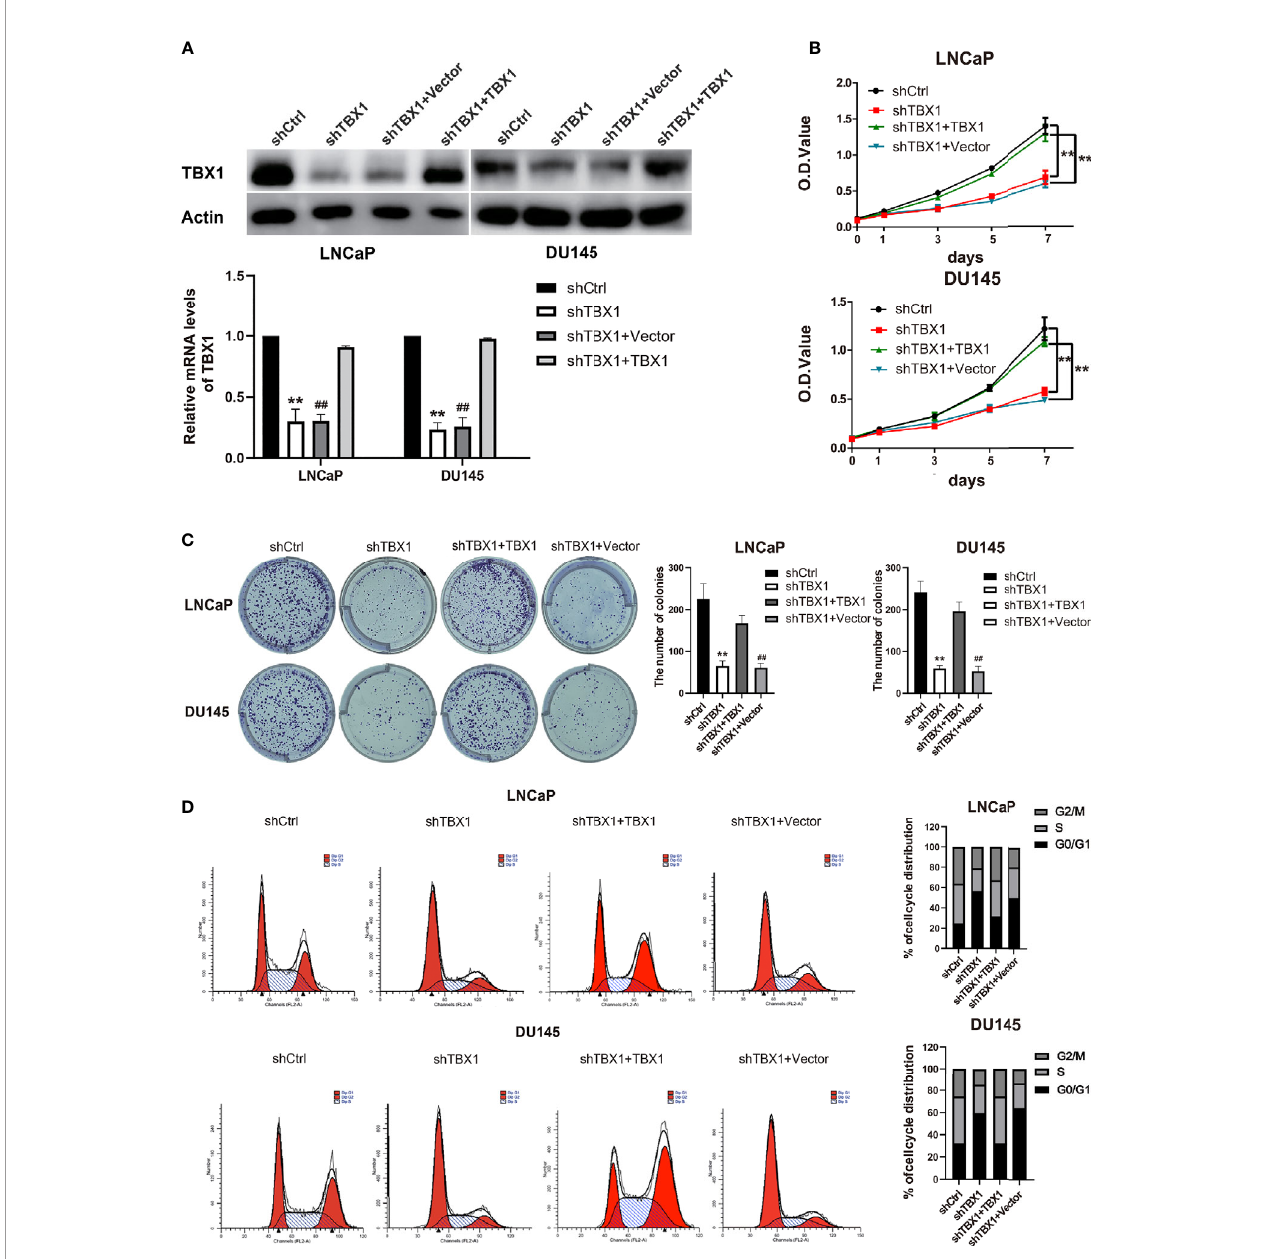
FIGURE 3 | TBX1 promotes PCa cell growth in vitro . (A) Western blot analysis (upper panel) and qPCR (lower panel) assay results showing that shTBX1 transfection dramatically decreases TBX1 expression and that the TBX1 expression plasmid increases TBX1 expression in LNCaP and DU145 cells. The data represent the mean ± SD of three independent experiments. (B) TBX1 silencing dramatically inhibits PCa cell viability, which is rescued by the exogenous expression of TBX1. The data represent the mean ± SD of three independent experiments. (C) TBX1 silencing signi fi cantly inhibits the colony formation of PCa cells, which is rescued by the exogenous expression of TBX1. Left panel, representative images of colony formation. Right panel, quantitative analysis of colon numbers. The data represent as the mean ± SD of three independent experiments. (D) TBX1 silencing increases the percentage of cells in the G0/G1 phase. Cell cycle distributions were investigated by fl ow cytometry. The data represent the mean ± SD of three independent experiments. **, p < 0.01, shTBX1 vs. shCtrl/shTBX1+TBX1; ## , p < 0.01, shTBX1+Vector vs.